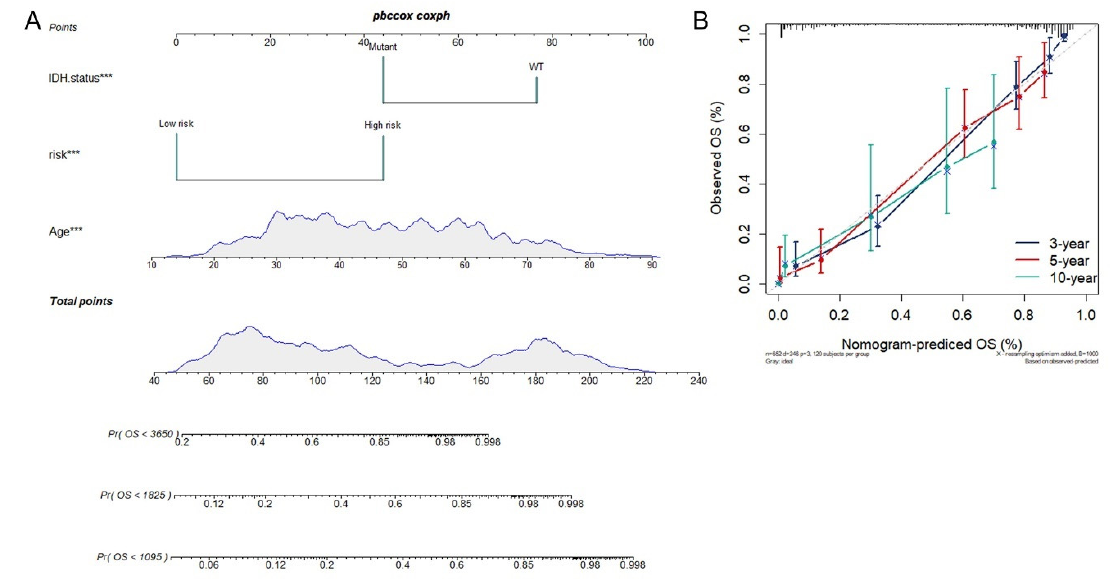
Figure 5. Construction of integrated models to predict survival in glioma: ( A ) Nomogram for predicting the 3/5/10-year overall survival in glioma patients. ( B ) Calibration curve for the prediction of 3/5/10-year overall survival. ***, p < 0.001.